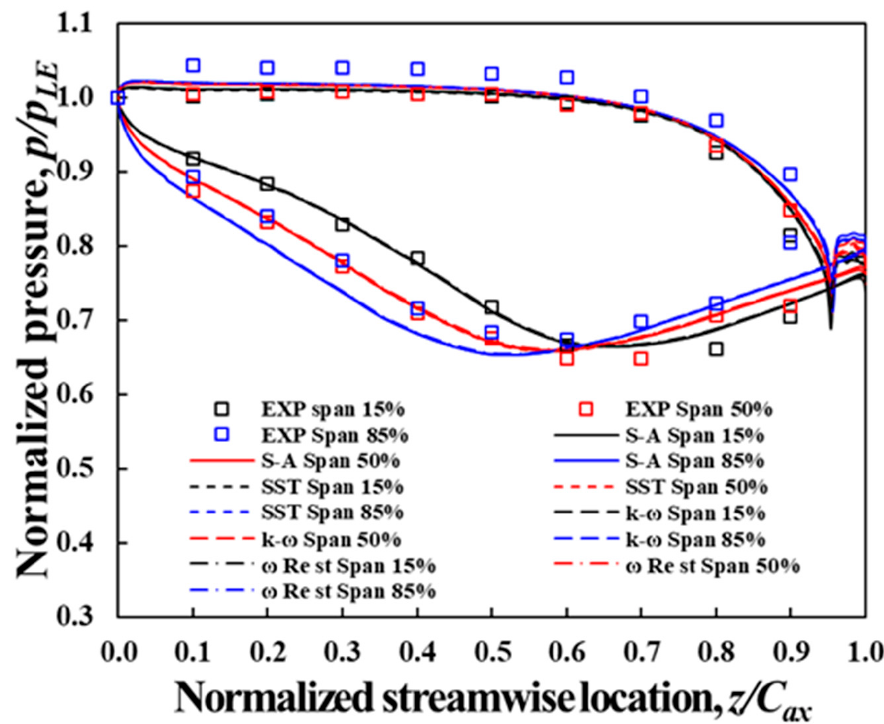
Figure 6. Comparison of surface pressure distribution of NGV.